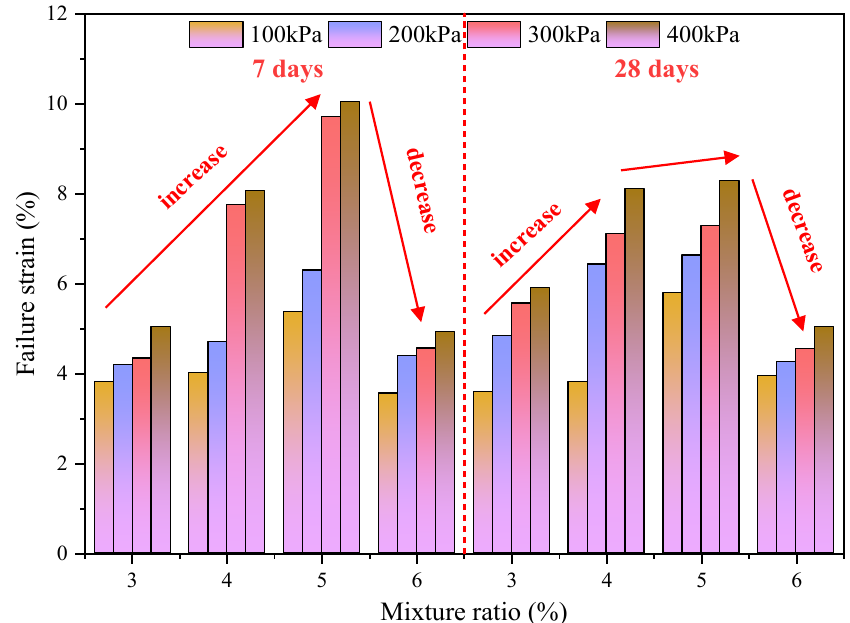
Figure 8. Failure strain.